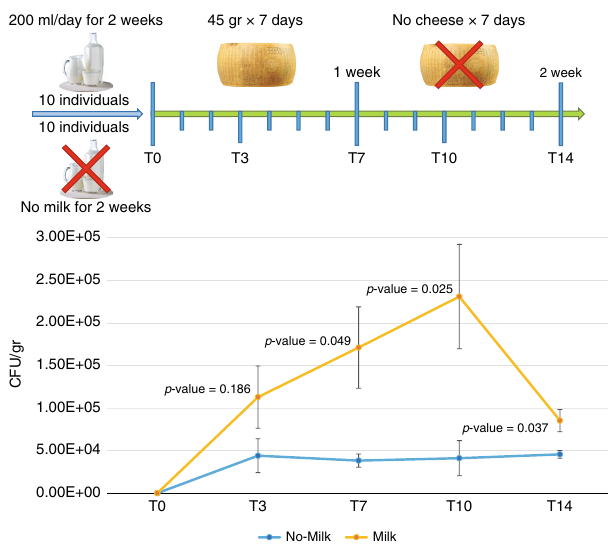
Fig. 5 Evaluation of the performance of B. mongoliense BMONG18 in achieving human gut colonization and persistence. The graph shows the average abundance of B. mongoliense BMONG18 observed in the enrolled 10 Milk and 10 No-Milk individuals at multiple time points, as described in the study plan schematized in the upper part of the image. Error bars represent the standard deviation. P-values obtained from Student t test between Milk and No-Milk individuals are reported in the graph for each sampling